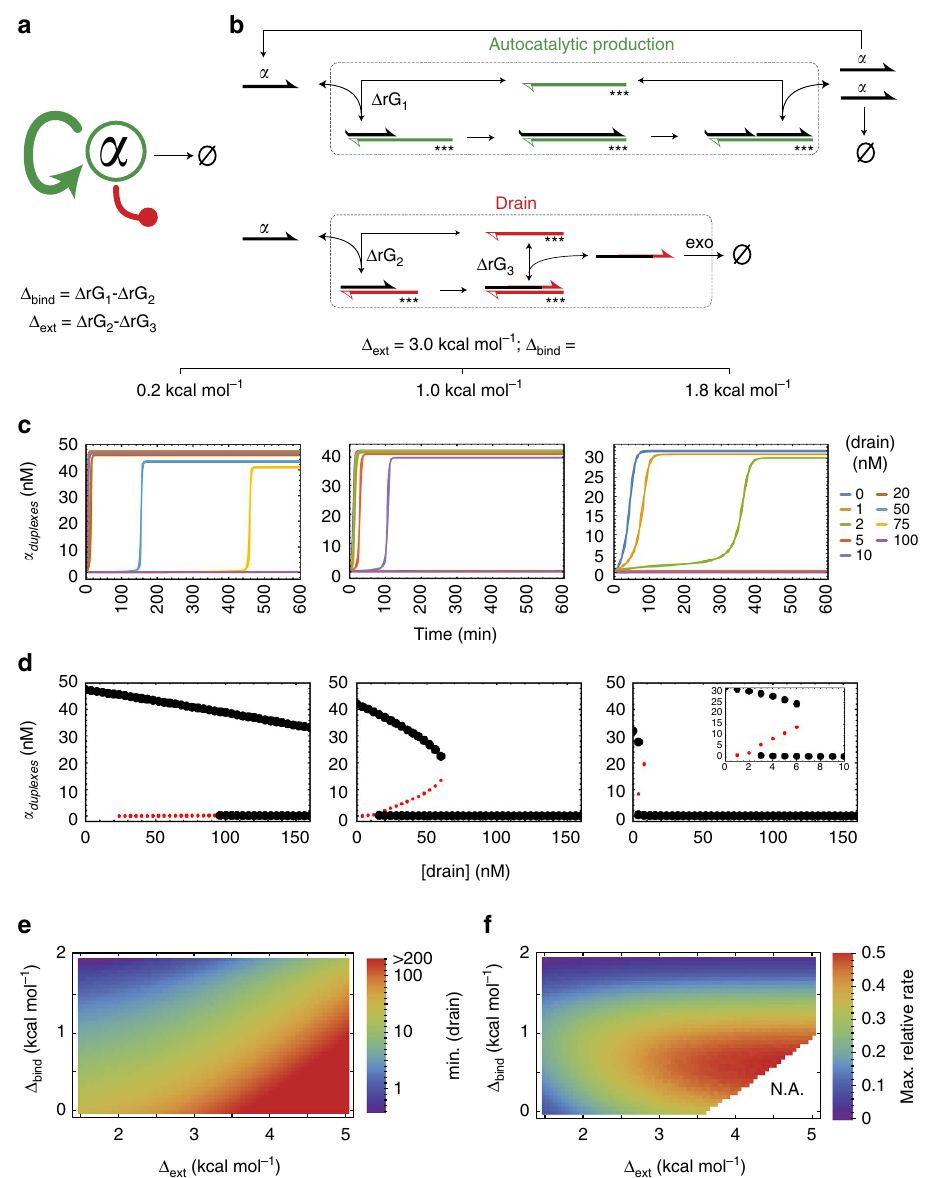
Figure 2 | Drain-based bistability design for the PEN DNA toolbox. ( a ) Schematic representation of a simple autocatalytic network with a sink and an additional decay pathway (dead-ended red arrow). The concentration of a is the dynamic variable considered here. ( b ) The species-specific and saturable degradation pathway is constructed from a short drain template that is able to bind the input a , extend it with a few additional bases and slowly release this deactivated species for eventual degradation. The difference between the binding strength on the drain and on the replication template ( D bind ) controls the respective reaction fluxes at low a concentration. The maximum throughput of the drain pathway depends on the dehybridization step, hence it is governed by the stabilization of the trigger upon extension on the drain ( D ext ). Empty arrowheads show non-extensible 3 0 -ends (3 0 phosphate modification), and *** denotes the protection against exonuclease degradation (backbone modification). ( c , d ) Predicted time traces and fixed points (stable in black, unstable in red), computed at D ext ¼ 3.0kcalmol (cid:2) 1 using a complete kinetic model. The y axis corresponds to the total concentration of complexes involving a . Curves suggest that the bistable behaviour can be observed for a variety of D bind values, if enough drain is present. Higher D bind require less drain, but lead to sluggish amplifications and quickly fall back in a monostable trivial behaviour. ( e ) Computed concentrations of drain template necessary to reach the bistable regime in the D bind / D ext parameter space (taken to reflect 0–3 deletions on the template and 2–6 bases on the drain tail). ( f ) Computed maximum amplification rates compatible with bistability (that is, at the minimal drain concentration). Values corresponding to drain concentrations above 200nM were not